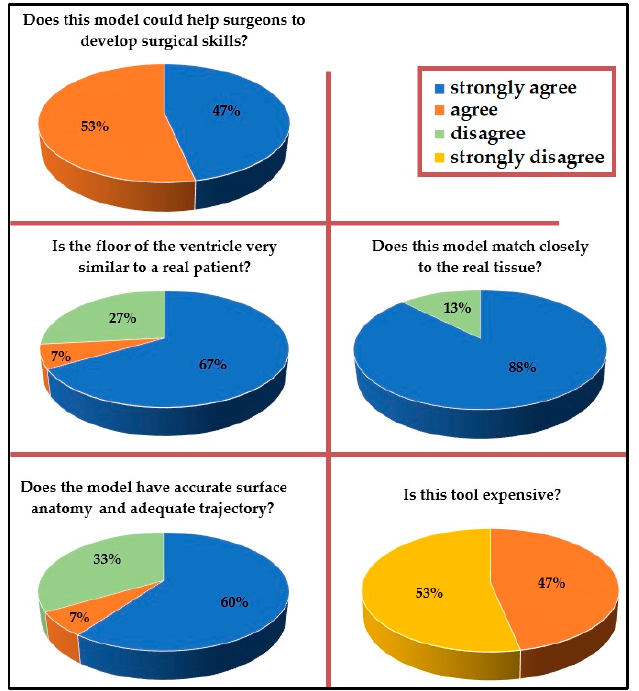
Figure 7. Answers of all neurosurgeons after trying the simulator.